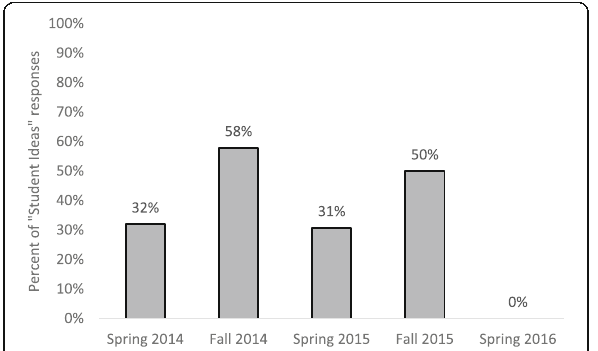
Fig. 4 Mental models term usage. Percentage of responses to the teach and learn prompts that were coded as student ideas that also contained the term “ mental models ”